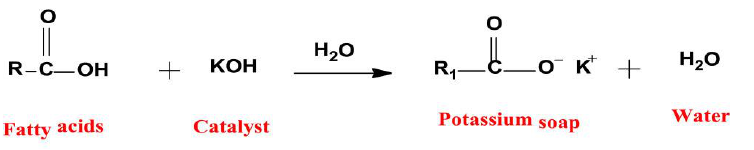
Figure 5. Saponification reaction mechanism. Data adapted from [71], published by Elsevier, 2022. 2.2. Homogeneous acid Catalysts Acid catalysts have a better tolerance level in processing waste oils for biodiesel pro- duction than base catalysts. In two-step transesterification processes, acid is preferred as a catalyst first followed by a base for better results, especially when using organic sub- strates. Homogeneous acid catalysts can be used to synthesize biodiesel from renewable feedstocks such as animal fat, grease, and waste cooking oil [28]. The kinetics of the ho- mogeneous phase catalyzed ester exchange reaction of soybeans was thoroughly studied by Nogales-Delgado et al. [74]. As a conclusion, a pseudo-first-order reaction mechanism was applied in all cases, with activation energies of 65.5–66 and 92.3 kj·mol −1 for KOH and CH 3 C 6 H 4 SO 3 H, respectively, proving the higher activation energy for acid catalysis com- pared to base catalysis. However, the process of synthesizing biodiesel with acid catalysts has many downsides, including slow reaction times, and it requires increased quantities of methanol. Iram et al. [75] used a raw material with a methanol to vegetable oil molar ratio of 2:1 and produced biodiesel using transesterification. It was found that higher methanol to vegetable oil molar ratios were required to reduce the acidic value of the cat- alyst used for the transesterification to within its desired limits. In addition to slow reac- tion times, homogeneous acid catalysts are corrosive, lead to excessive amounts of wastewater, and complex procedures are required to separate the catalyst from the reac- tion products for reuse [34]. Moreover, they are prone to residual acid, which leads to the production of substandard biodiesel [76]. This has led to the development of heterogene- ous acid catalysts for this process. 2.3. Homogeneous Base Catalysts In industrial-scale biodiesel production, the most common homogeneous base cata- lysts are usually KOH and NaOH. They have been shown to have high catalytic activity and are traditionally used commercially as low-cost catalysts [77]. Furthermore, homoge- neous base catalysts are the most viable catalysts for mass production because the trans- esterification process using base catalysts is performed under low pressure and tempera- ture conditions, conversion rate is faster in a short period of time, the conversion rate is outstanding with no intermediate steps, and the process is cost effective [27,78]. In fact, it was reported that the rate for a base-catalyzed reaction would be 4000 times faster com- pared to an acidic catalyst [27]. Chamola et al. [79] used NaOH in the transesterification of dry algae and achieved maximum biodiesel yields of 87.42%. Likewise, Sendekie et al. [80] investigated the conversion of biodiesel from desert date seed kernel oil with a NaOH